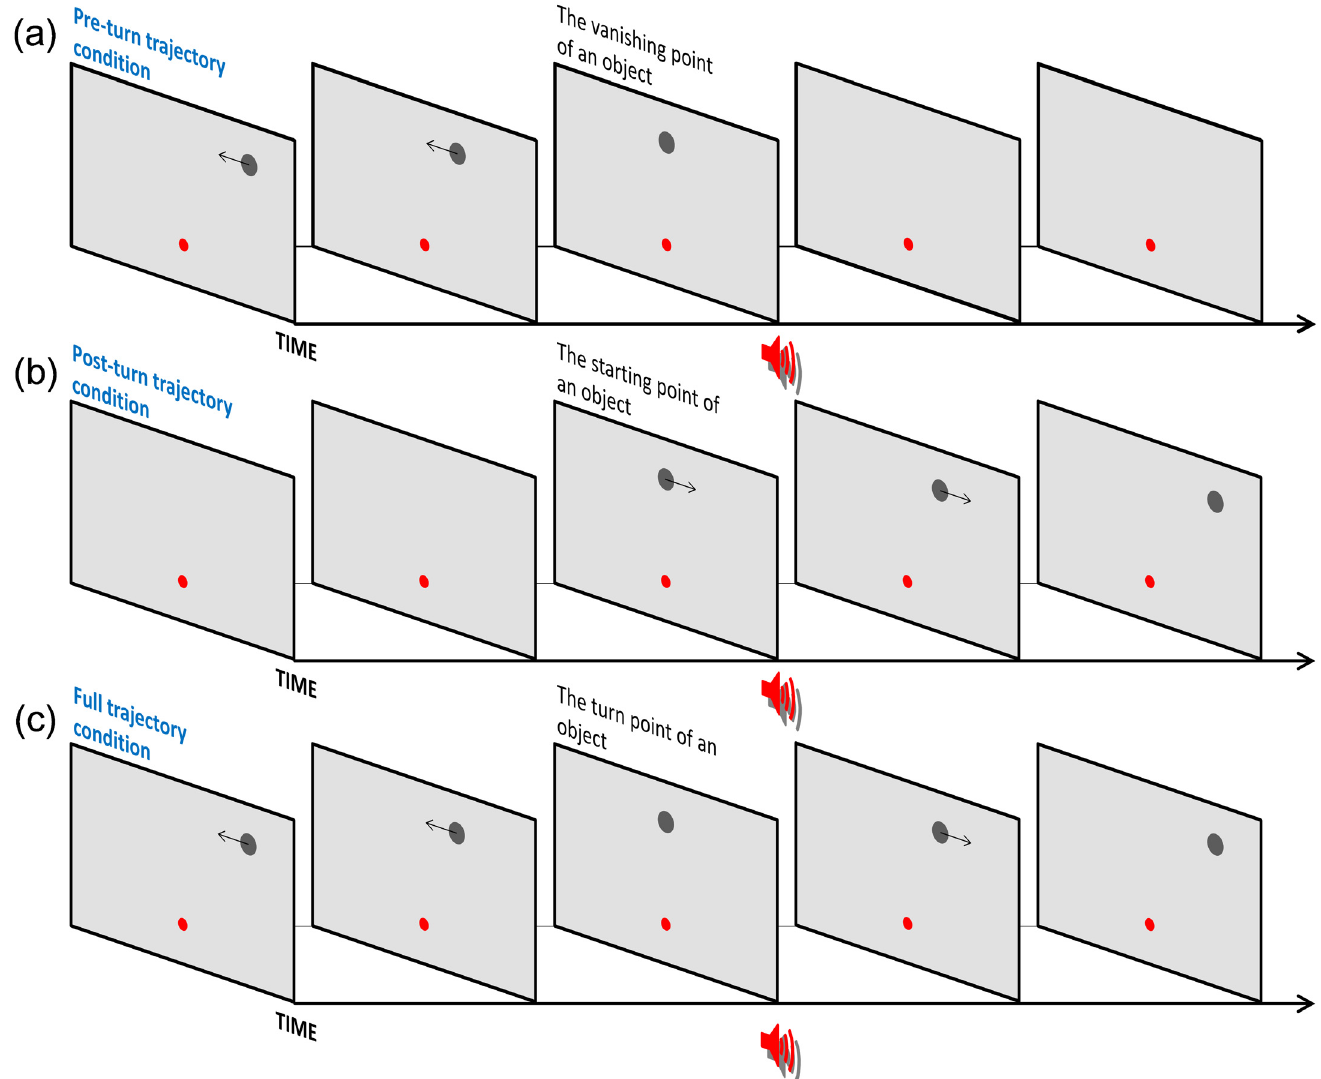
Fig 4. Schematic illustration of stimuli used in Experiment 3. (a) Pre-turn motion trajectory condition: the object moved proximal to the fixation point for 690 ms and then disappeared without the object turning. (b) Post-turn motion trajectory condition: the object appeared proximal to the fixation point, moved away from this location for 690 ms, and then disappeared. (c) Full motion trajectory condition: the object moved proximal to the fixation point for 690 ms, reversed its motion, and returned to the original